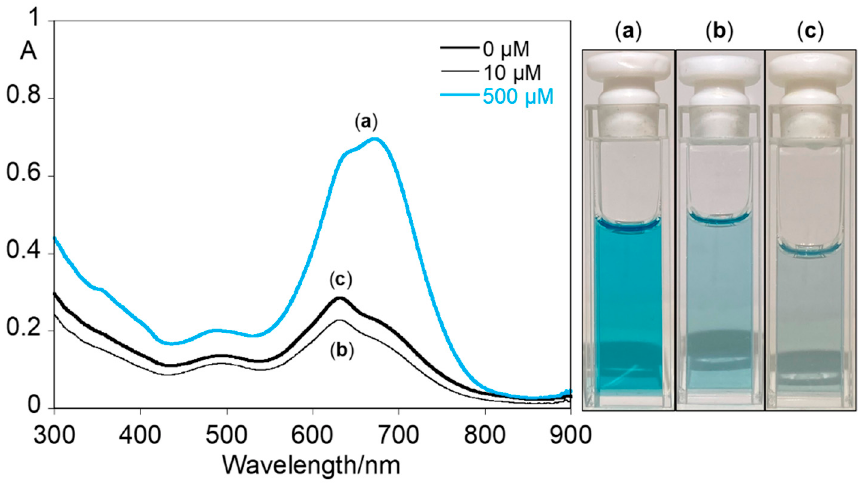
Figure 6. Absorption spectra and images of Cy1 -doped PMMA nanoparticles synthesized with ( a ) 0, ( b ) 10 and ( c ) 500 µM of CTAB. ( b ) 10 and ( c ) 500 µ M of